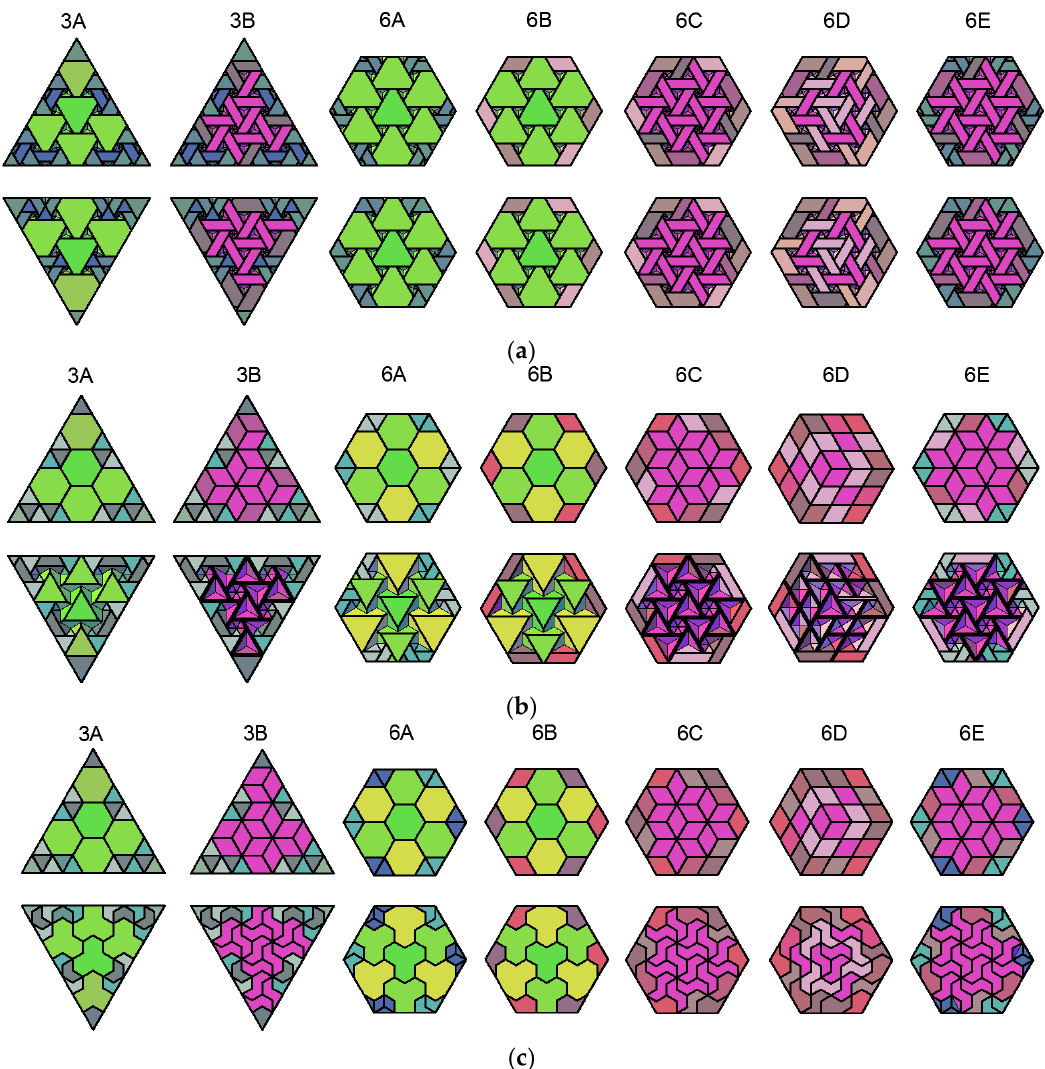
Figure 22. Triangular and hexagonal slabs well-fitting to vertical faces of beams: ( a ) both sides rugged; ( b ) one side smooth; and ( c ) both sides smooth.